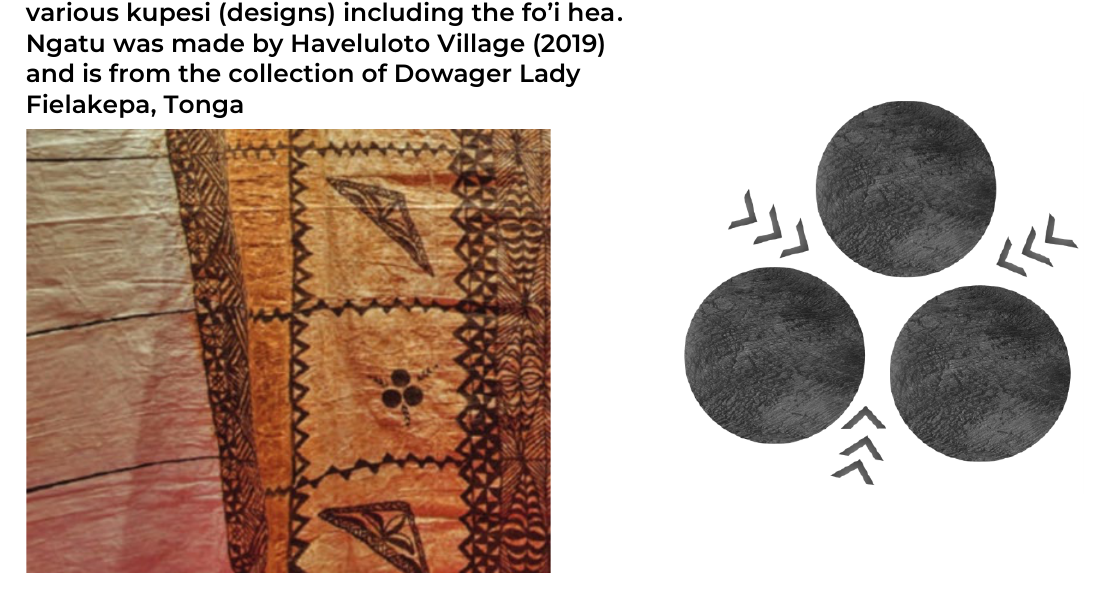
Figure 2. The fo’i hea